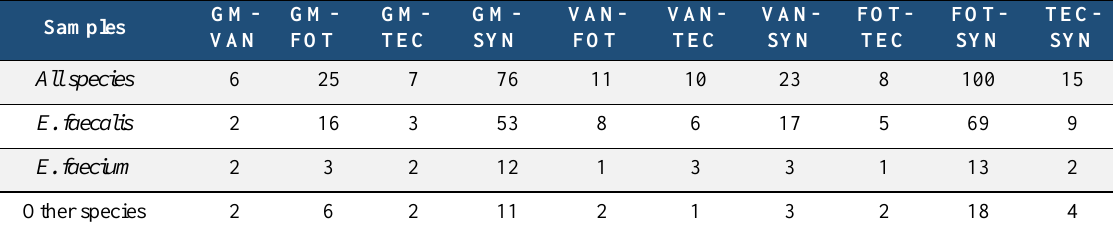
Table 6. The number of samples with co-resistance to different antibiotics by the antibiotics.